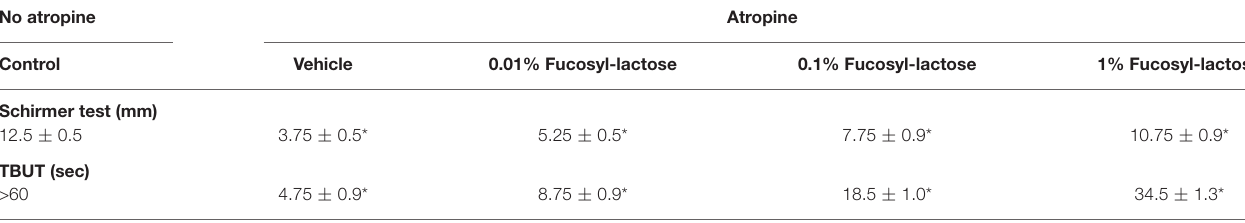
TABLE 1 | Tear volume (Schirmer test) and tear break up time (TBUT) after 24 h from the first atropine administration. No atropine